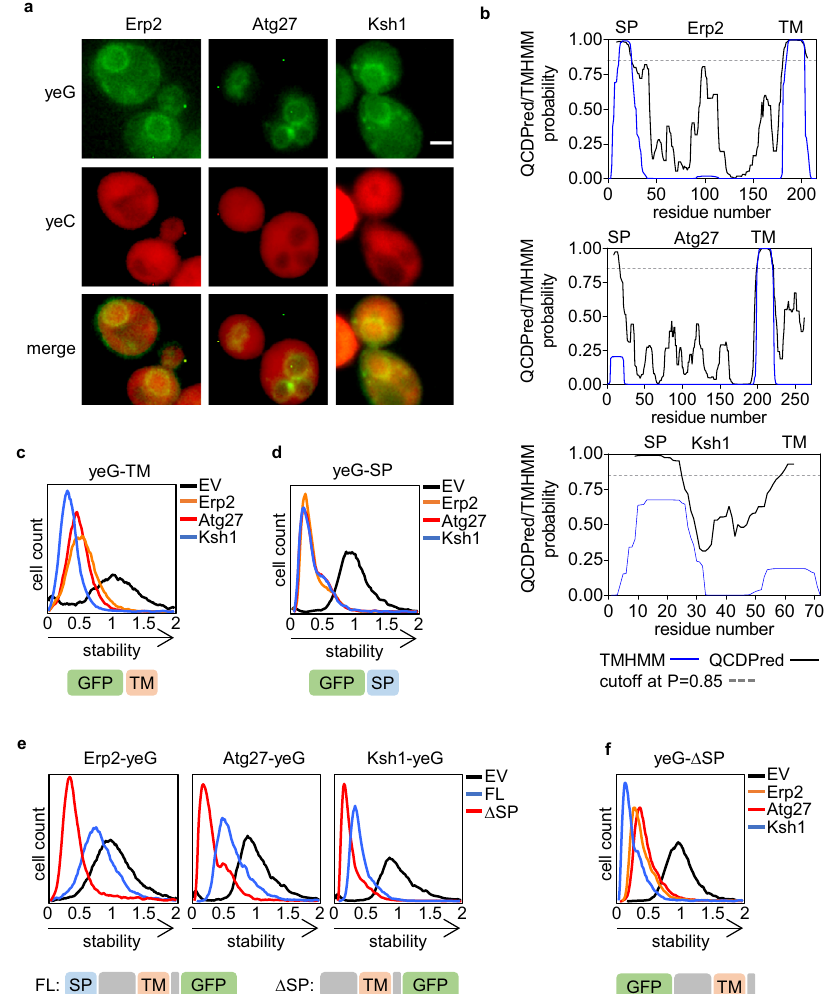
Fig. 4 | Transmembrane domains function as QCAP degrons. a Represantitive fl uorescenceimagesdemonstratingmembranelocalizationofthesingle-passtype- 1 TM proteins, Erp2, Atg27, and Ksh1. Scale bar- 2 μ m. b Map of QCDPred and TMHMM predictions of Erp2, Atg27, and Ksh1 degron and TMD probabilities, respectively.AdegroncutoffprobabilityismarkedatP=0.85byadashedgrayline. c – f Flowcytometryhistogramsof the normalized yeG/yeC ratioin cells expressing ( c ) C-terminal appended TMDs, ( d ) C-terminal appended SPs, ( e ) N-terminal